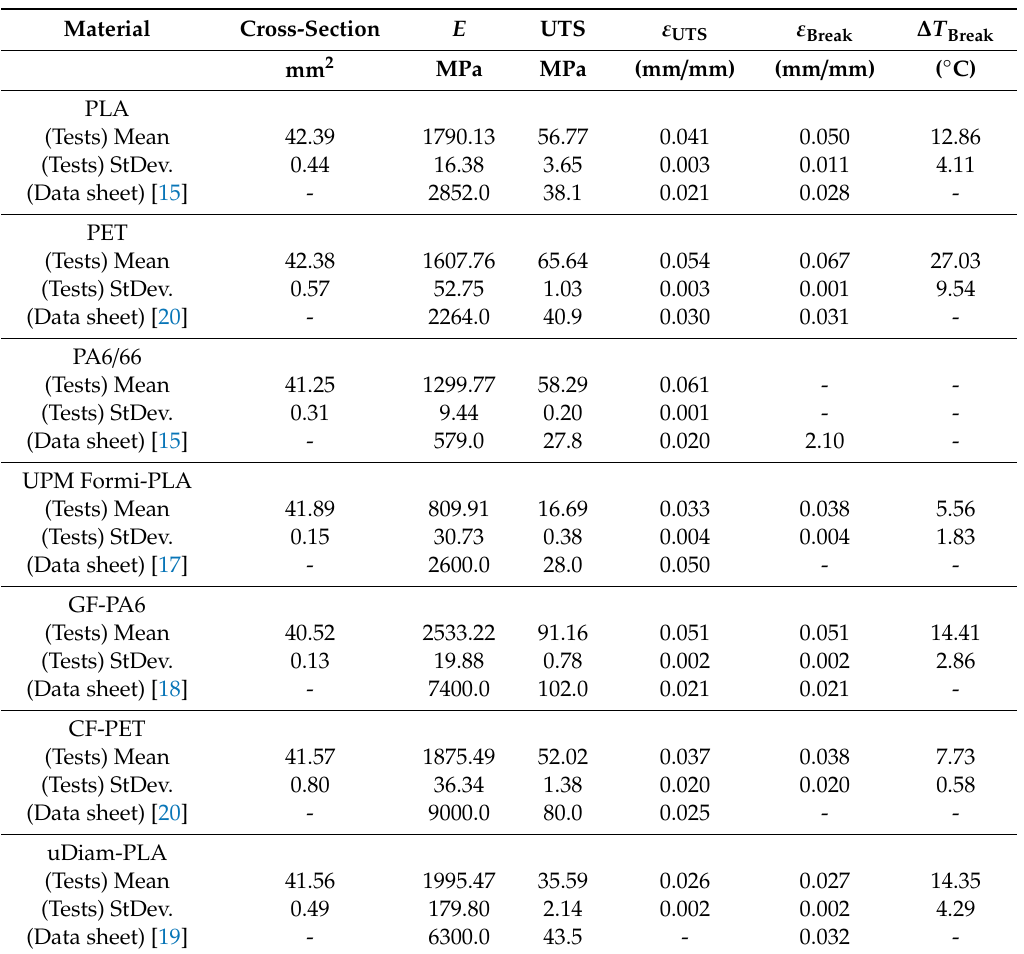
Table 4. Mechanical and thermal characterization of investigated materials under tensile loading. Here, E , UTS, ε UTS , ε Break and ∆ T Break refer to Young’s modulus, ultimate tensile strength, strain at ultimate tensile strength, strain at break and di ff erence between the temperature at break and initial configuration, respectively. StDev. refers to the standard